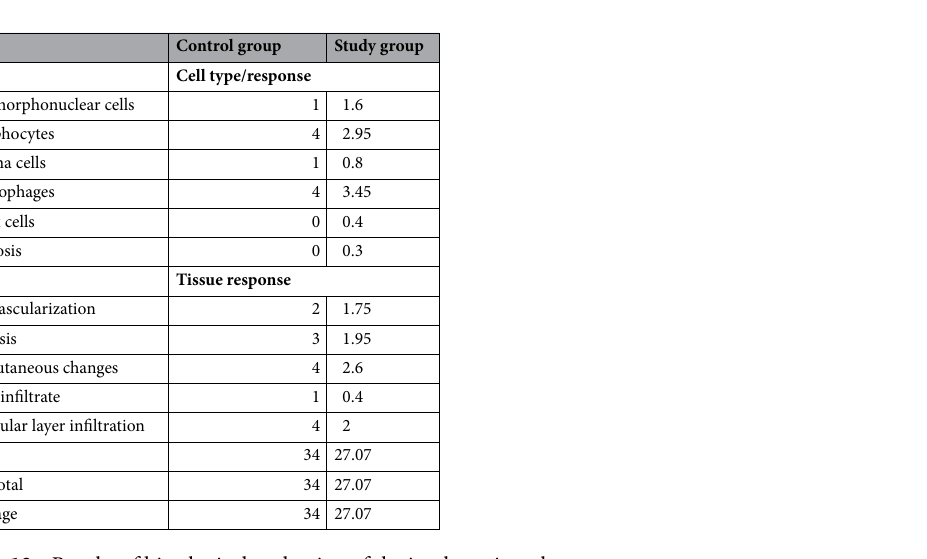
Table 13. Results of histological evaluation of the implantation